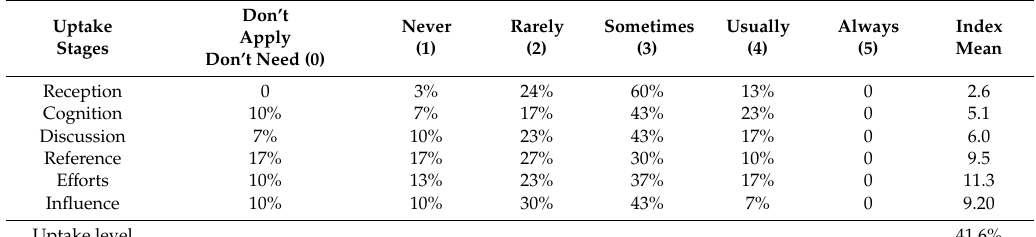
Table 5. Frequency distribution of stages and level of the